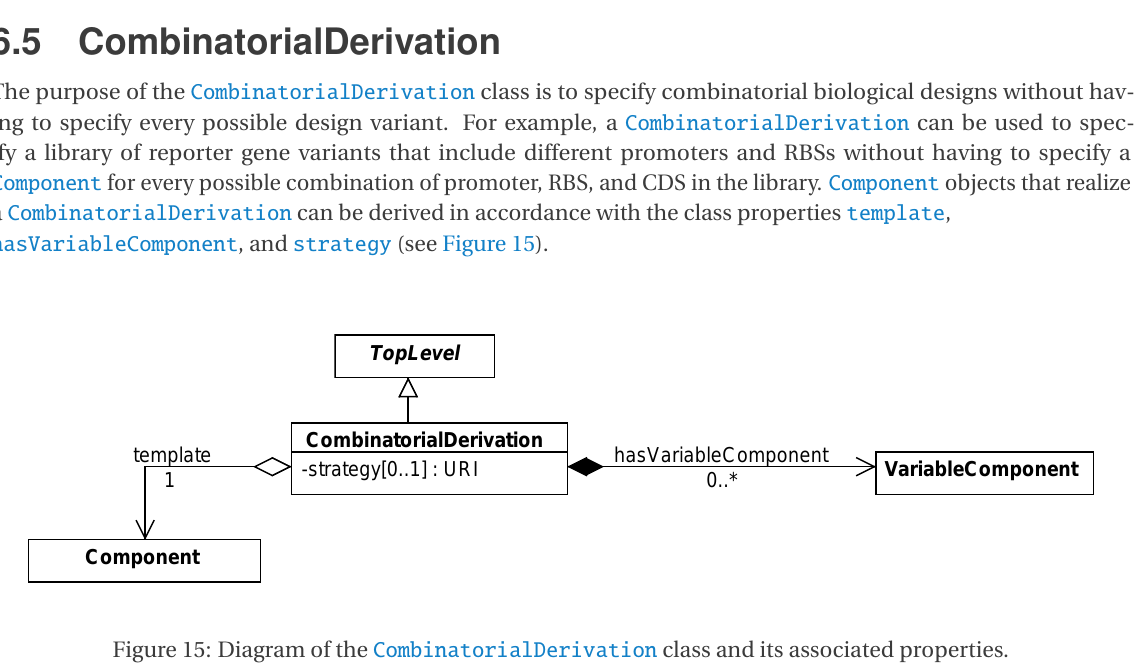
Figure 15: Diagram of the CombinatorialDerivation class and its associated